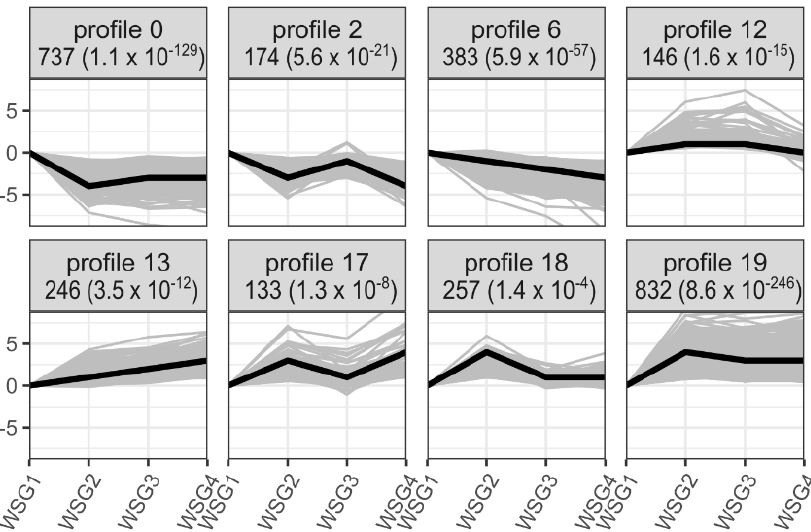
Figure 4. Significant temporal expression patterns of DEGs from all pairwise comparisons of WSG1-WSG4. All DEGs served as input in short time-series expression miner (STEM) analysis. The eight profiles suggesting the expression patterns of clustered genes are significant ( p < 0.05) are all shown. The number of DEGs for each profile are noted at the top of each panel followed by a p value in parentheses. Thin grey lines indicate expression patterns of each individual genes clustered in the profile, while thick black lines represent the expressional trend of each profile. WSG1-WSG4 on the x -axis represent 0, 4, 8, and 12 days of treatment, respectively, while the numeric values on the y -axis represent normalised expression values.